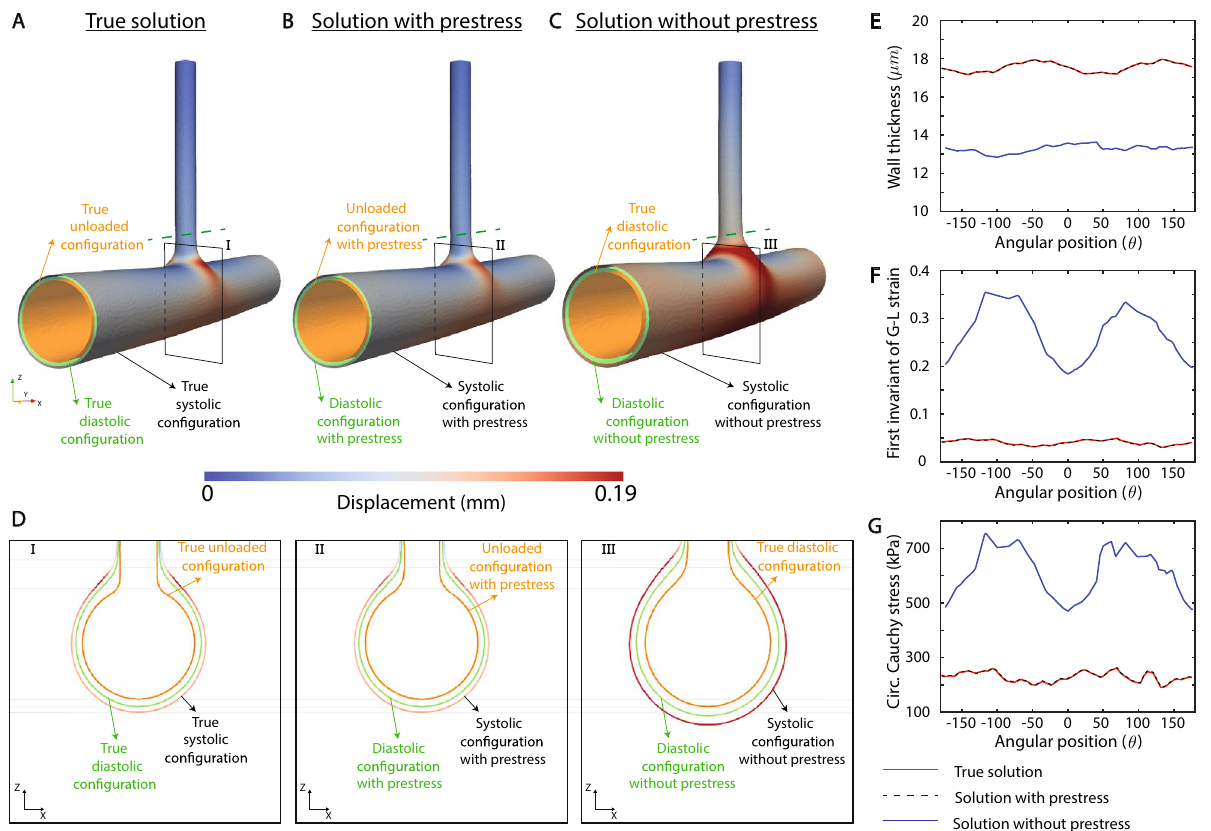
Figure 6. Prestress verification against forward solution. ( A – C ) show the different configurations pertaining to the true solution, solution with prestress, and solution without prestress, respectively. ( D ) shows the enlarged versions of these configurations along the planes I, II, and III indicated in ( A – C ). ( E – G ) show the comparison of circumferential variation of different metrics among true solution, solution with prestress, and solution without prestress at the side branch location indicated by dotted green line in ( A – C